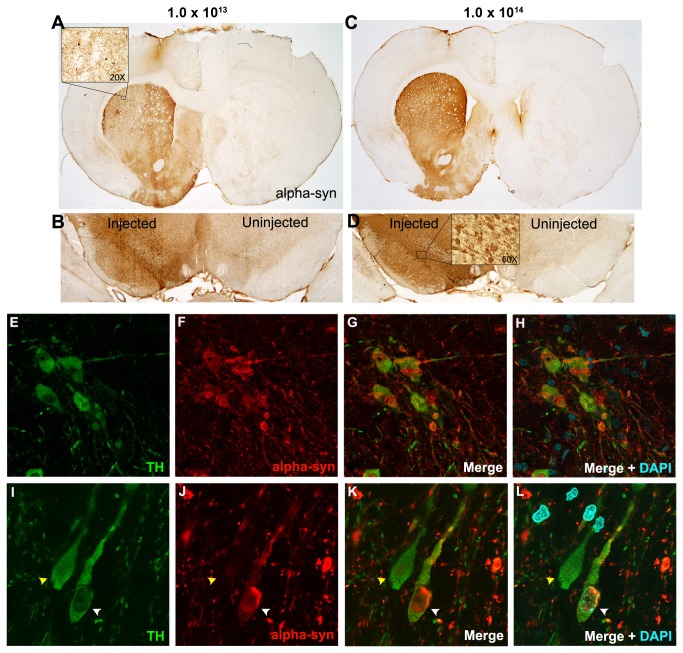
Human α-syn expression in the striatum and SN following intranigral rAAV2/5-α-syn injection.Representative samples of human α-syn immunoreactivity in rat striatum (A, C) and substantia nigra (B, D) following intranigral injection with rAAV2/5-α-syn. A-B. Transduction following injection of 1.0 x 1013 vg/ml titer rAAV2/5-α-syn. (A) α-syn immunoreactivity is observed throughout the striatum ipsilateral to injected nigra. Insert shows striatal α-syn positive neurites and protein aggregates (20X). (B) α-syn immunoreactivity observed in the injected SN. C-D. α-syn expression following injection of 1.0 x 1014 vg/ml titer rAAV2/5-α-syn. α-syn immunoreactivity in the ST (C) and SN (D) following vector injection. Insert shows α-syn positive nigral neurons at 60X. E-L. α-syn co-expression and aggregation within SNpc THir neurons. E-H. Lower magnification image of α-syn immunoreactive aggregation within THir neurons and surrounding neurites. I-L. THir neurons with (white arrow heads) and without (yellow arrow heads) α-syn accumulation at 168x.